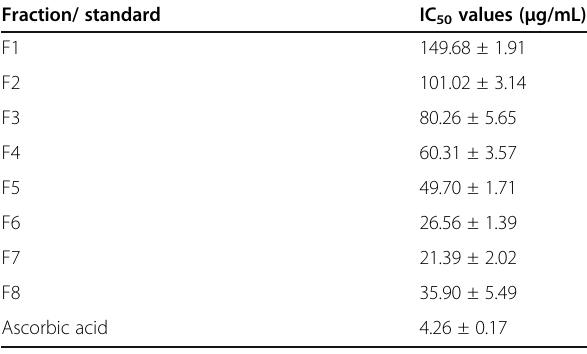
Values are represented as mean±standard deviation ( n